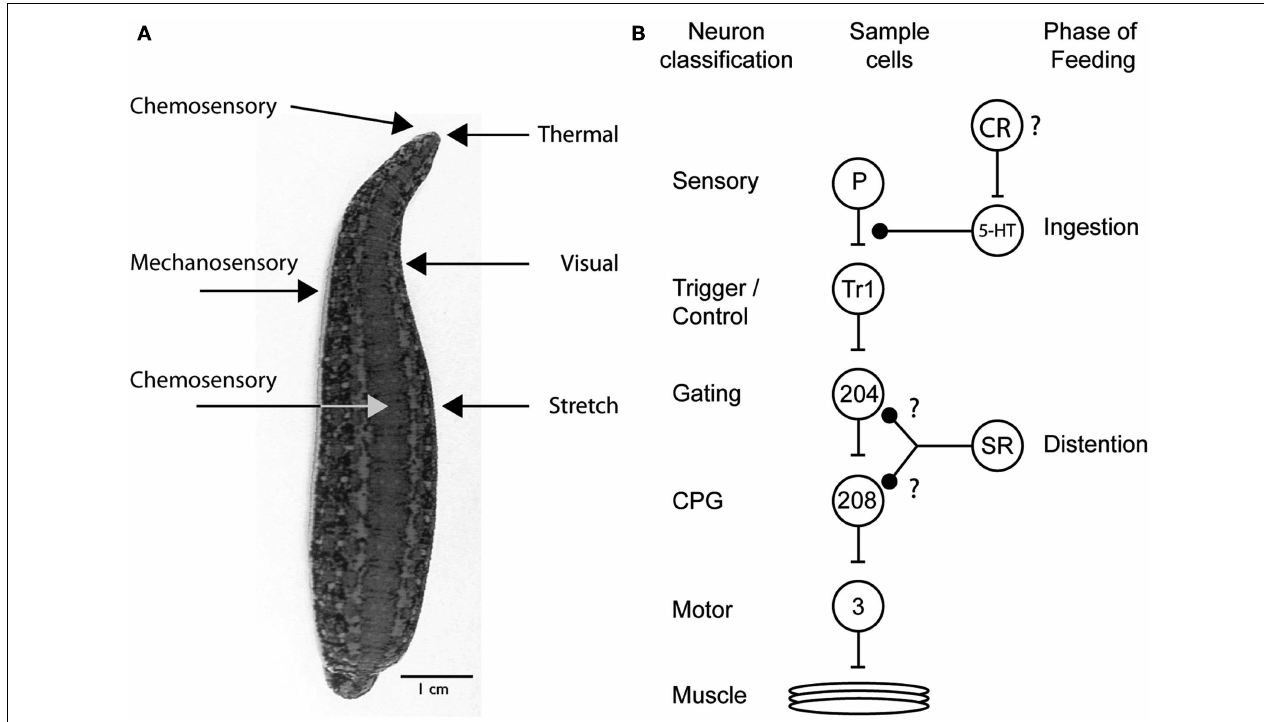
feedforward nature of the circuit but does not show the inhibitory interactions among the CPG neurons and between particular motor neurons.The inhibition from ingestion arises from an unknown source, probably chemical sensory pathways; it inhibits the P cell terminals via an unidentified serotonergic neuron.The actions of distention likely originate from stretch receptors in the body wall and target either the gating neurons or CPG neurons.The inhibition of cell 204 is speculative but consistent with an increase in swim period and a cessation of swimming behavior. Because leech stretch receptors hyperpolarize during stretch, the excitation of cell 208 may reflect the removal of inhibition rather than direct excitation.The swim circuit connections have been identified previously (Kristan et al., 2005). P, pressure mechanosensory P cell;Tr1, trigger neuron 1; 204, gating neuron 204; 208, CPG neuron 208; 3, dorsal longitudinal muscle excitatory motor neuron 3; SR, stretch receptors; CR, chemosensory receptor; speculated to encode distention; ?, potential